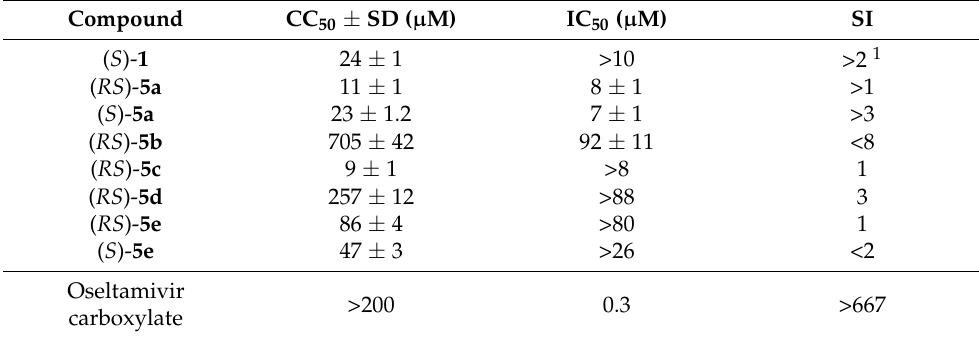
Table 2. Cytotoxicity and antiviral activity of compounds 5a – e against influenza A/Puerto Rico/8/34 (H1N1) virus in the MDCK cell